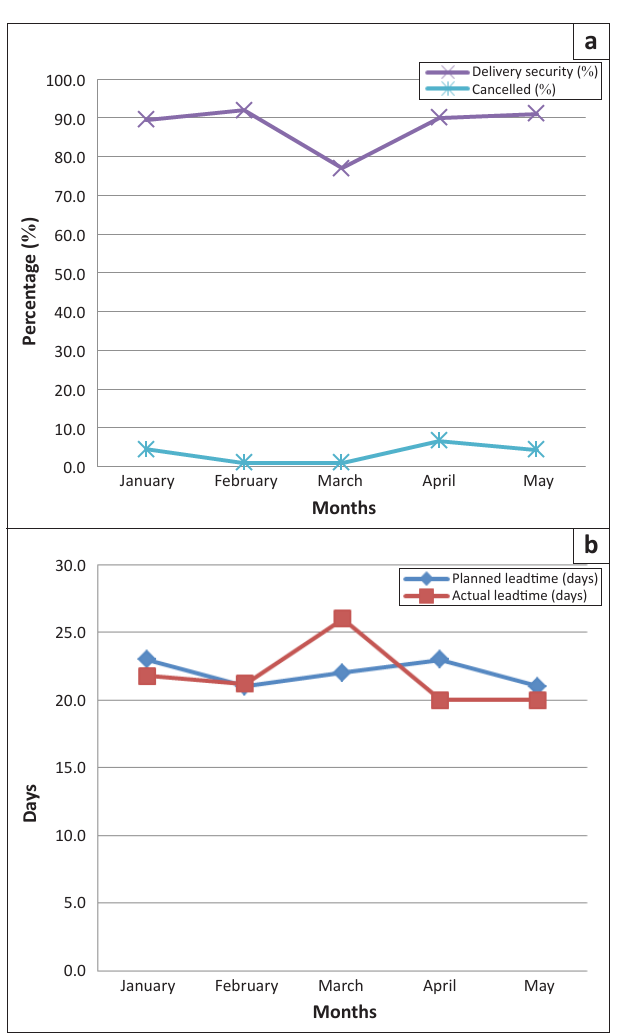
FIGURE 2: Actual indicator scores (a) in percentage and (b) in days, achieved by Company X between January 2011 and May 2011.